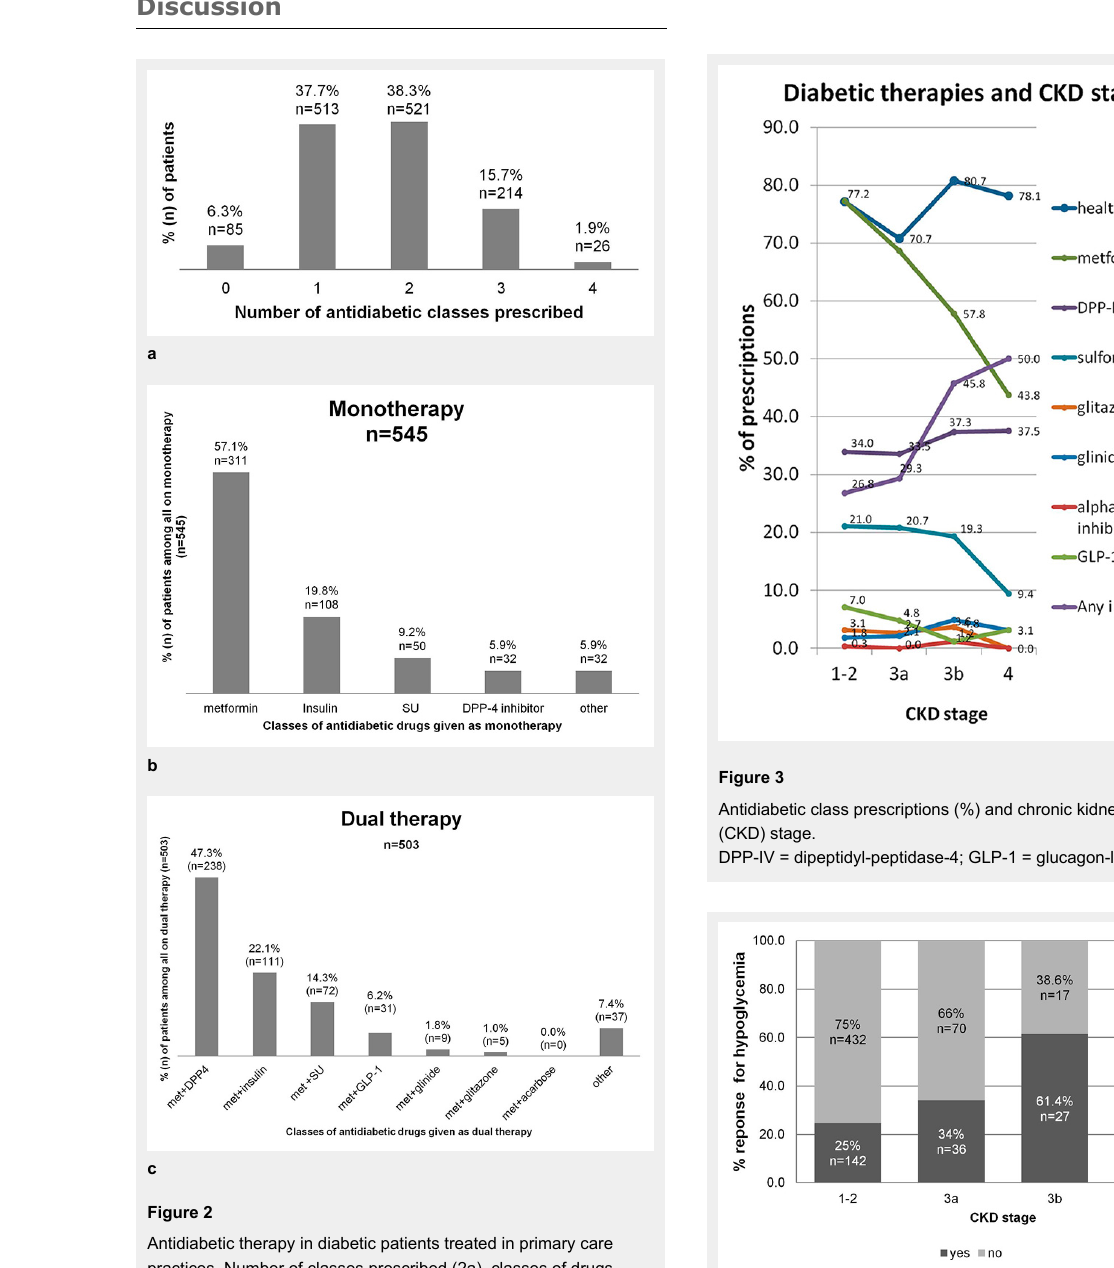
Figure 2 Antidiabetic therapy in diabetic patients treated in primary care practices. Number of classes prescribed (2a), classes of drugs prescribed as monotherapy (2b), classes of drugs prescribed as dual therapy (2c).